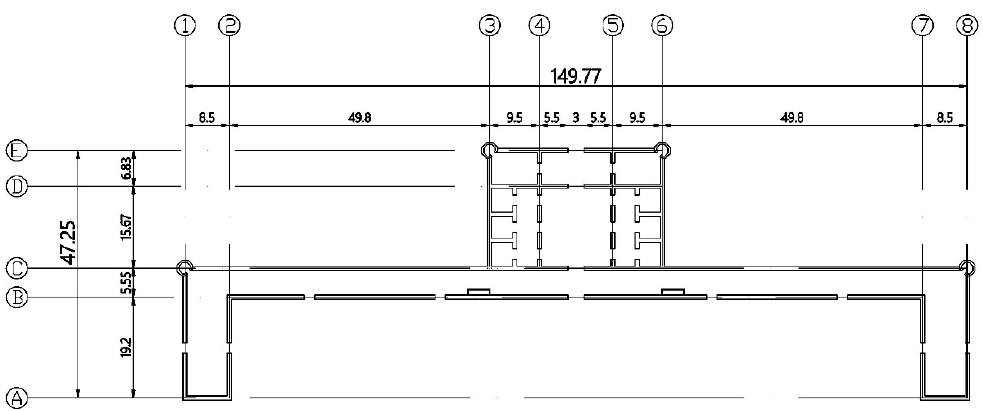
Figure 4. Plan view of the Government Building of the General Archive of the Nation (AGN) (dimensions in m) [12].